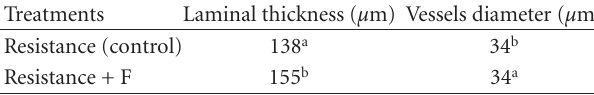
Table 5: Some anatomical parameters in recovered treated resistant biotypes of E. crus-galli, that is, laminal thickness and vessel diameters after 21 days of treatment with fenoxaprop-p-ethyl compared with untreated resistant